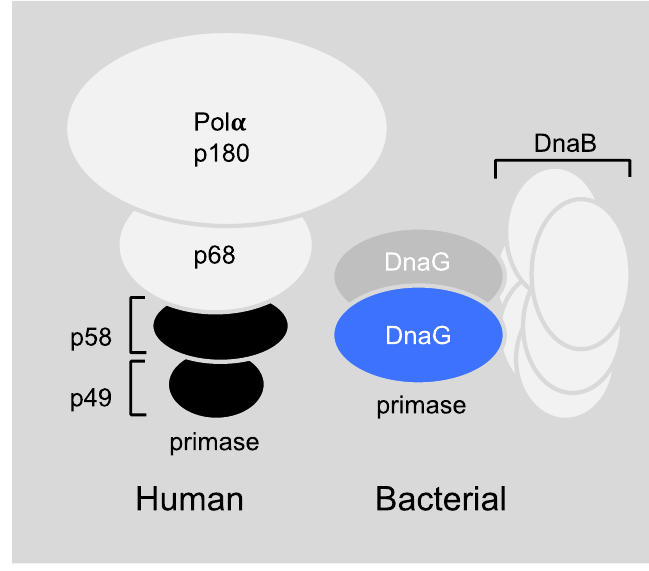
Figure 3. Schematic models of prokaryotic primase vs. eukaryotic primase. ( Left ) The DNA polymerase α–primase complex from human consists of four subunits. The p180 subunit is pol α, p58 and p49 comprise primase and p68 is the fourth, tightly bound subunit. ( Right ) DnaG primase interacts with hexameric DnaB helicase, however, the exact stoichiometry of this interaction is not known. Bacterial DnaG primases are composed of three main domains (Figure 2): The N-terminal zinc binding domain (ZBD), the RNA polymerase domain (RPD), and the C-terminal helicase binding domain (HBD). While crystal structures of the DnaG domains have been reported, a full DnaG structure remains undisclosed.